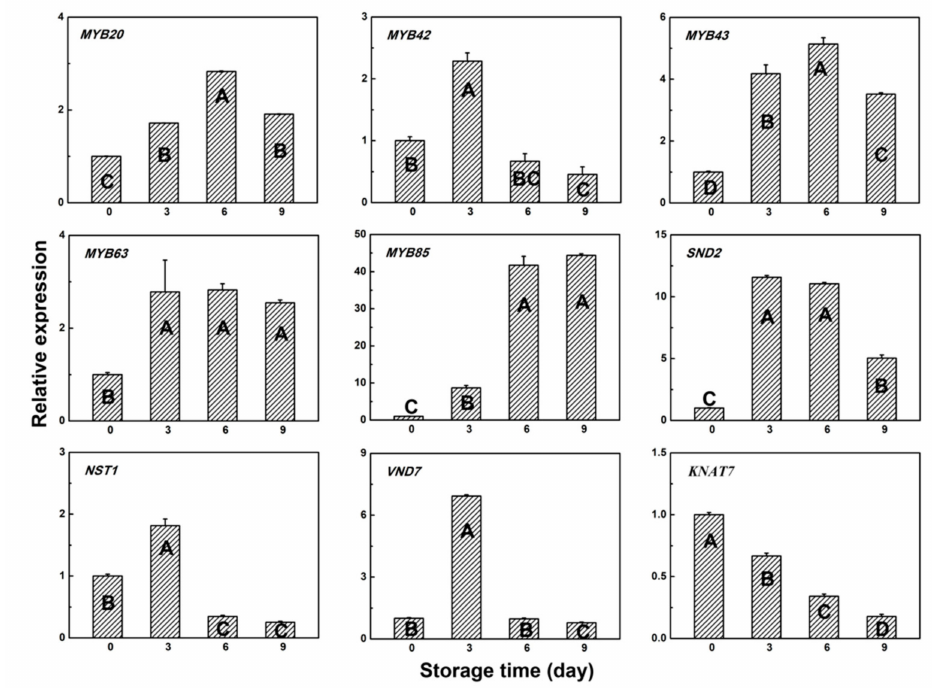
Figure 6. Relative gene expression patterns of transcription factors in MBSes during storage at 25 ◦ C. Error bars indicate the standard error. Uppercase letters indicate a significant di ff erence ( p < 0.05) among various storage times in